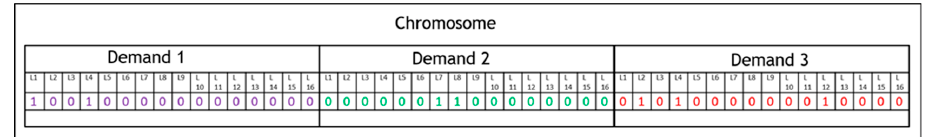
Figure 6. Structure of the chromosome.